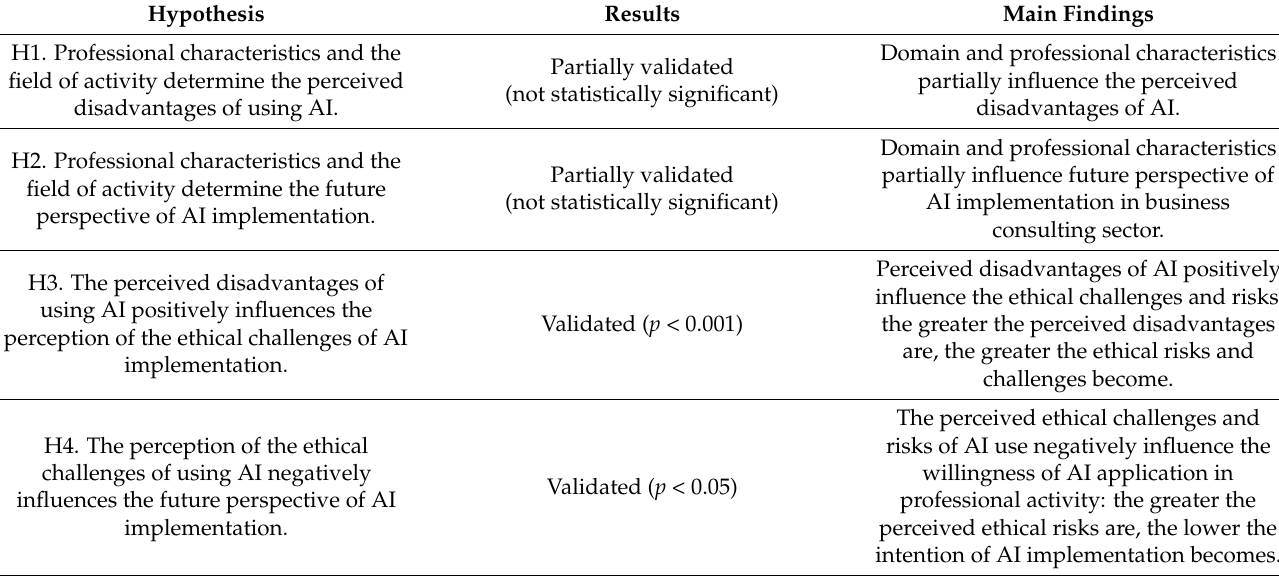
Table 3. Results of research hypothesis